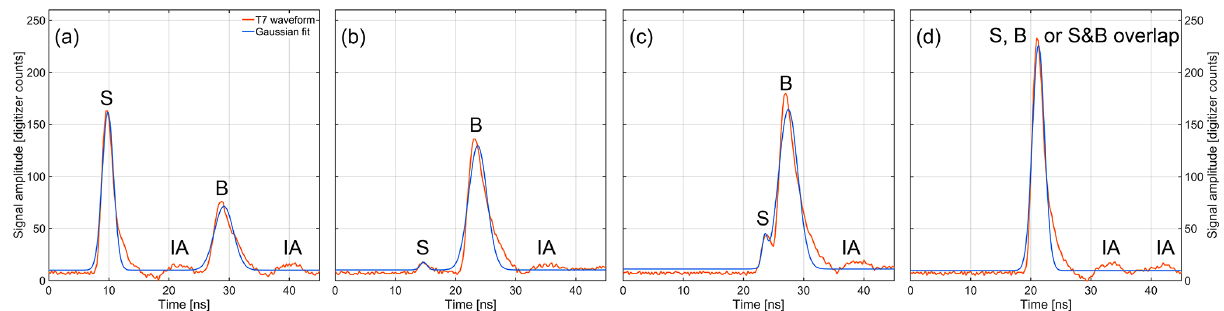
Figure 5. Example waveforms of lake return waveforms with Gaussian fits. S marks surface return, B marks bottom return, and IA indicates false return pulses that are caused by instrument artifacts (Fig.